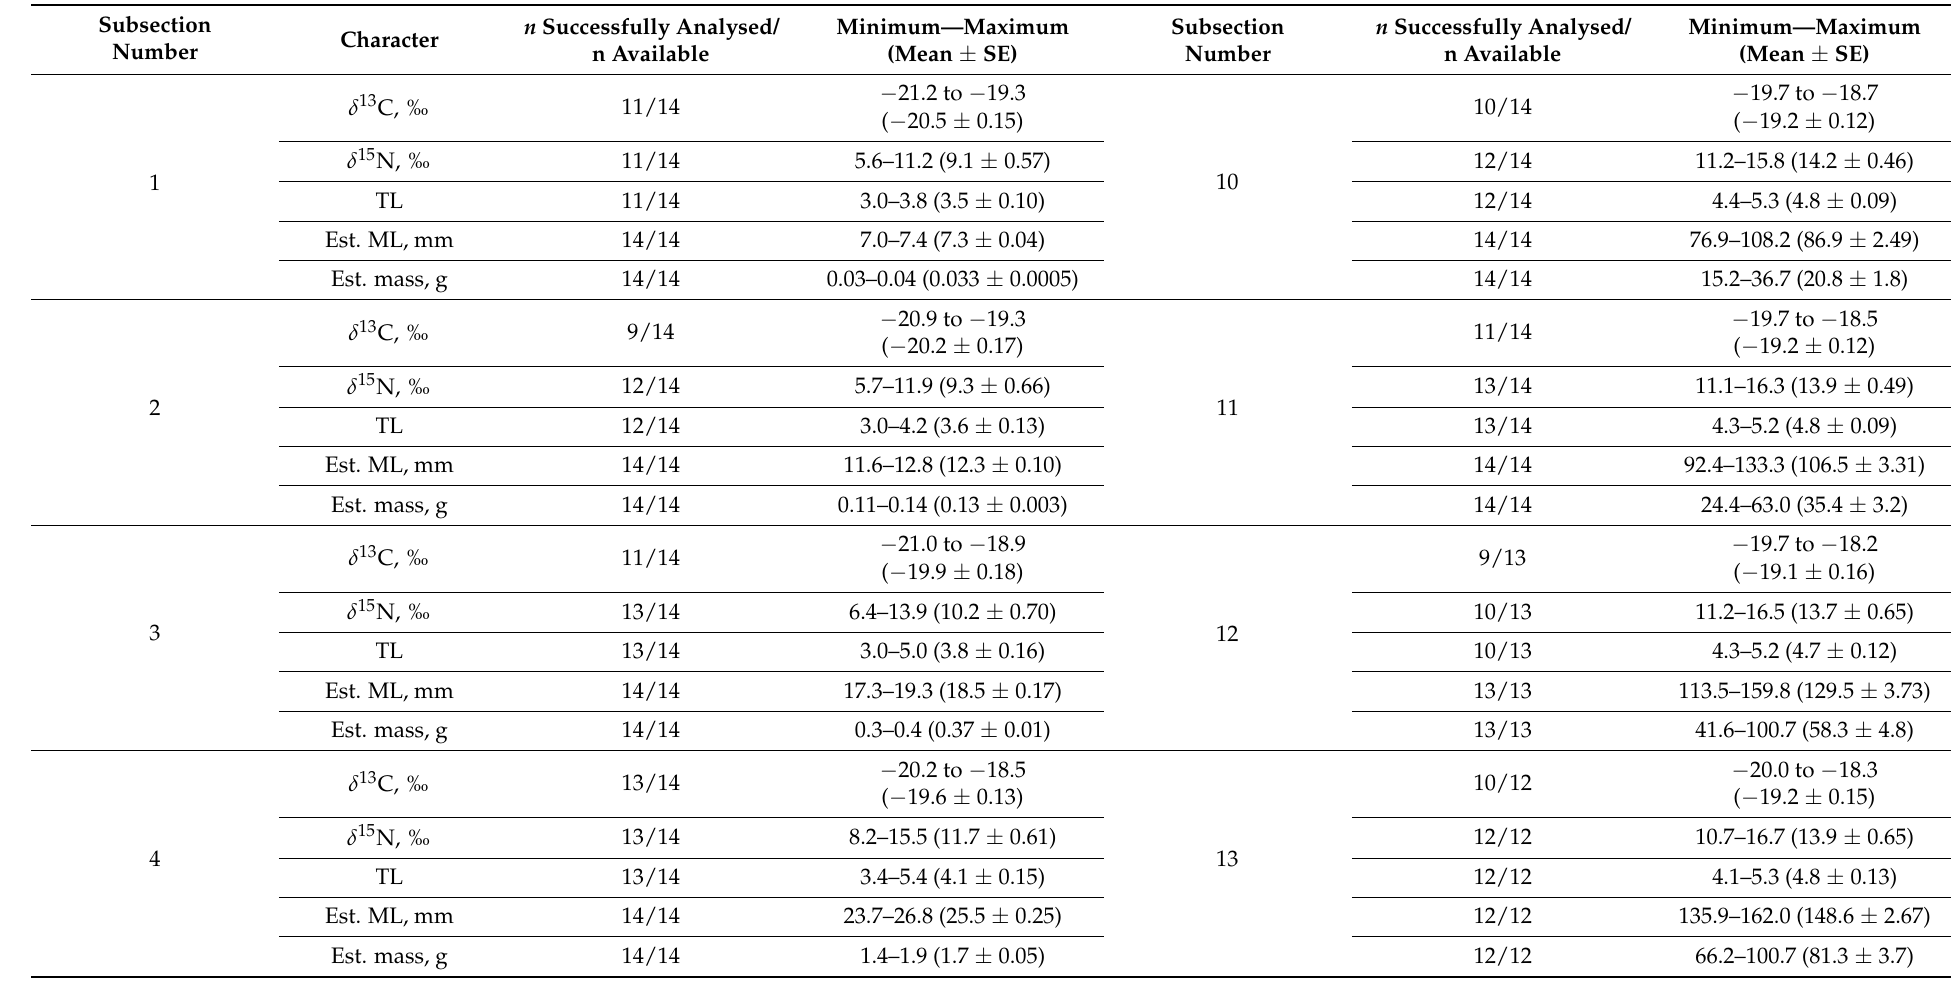
Table 2. Mean values of δ 13 C and δ 15 N, and estimated trophic level of all analysed upper beak subsections of Gonatus fabricii ( n = 179). ML: mantle length,